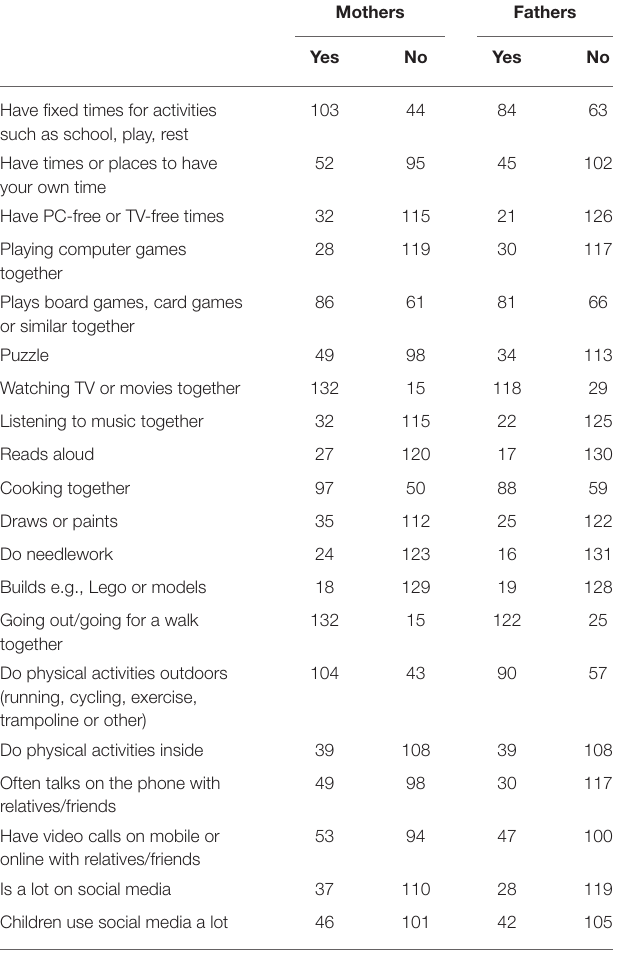
TABLE 2 | What do you do in the family to cope with the corona situation? Which of the following activities do you (or have you done) in the ongoing the corona